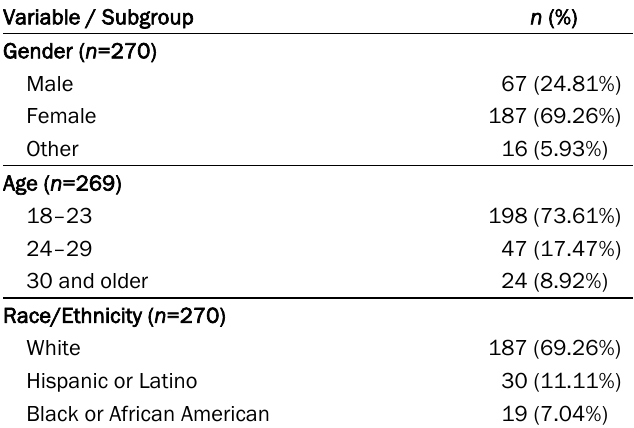
Table 2. Demographics of Farm-to-Fork (F2F) Evaluation Survey Respondents ( N